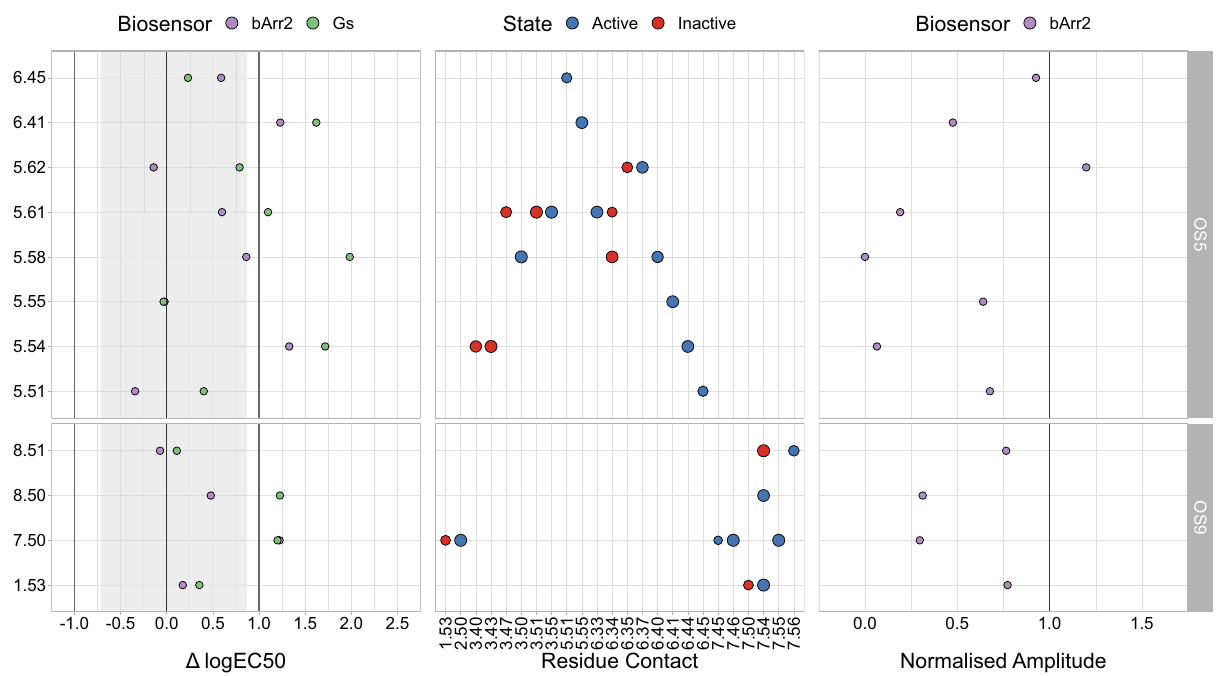
Fig. 4 Experimental data for OS5- and OS9-mutants in the β 2 AR. The y-axis depicts the position of the pocket residues (Ballesteros-Weinstein numbering 35 ). The left panel shows the difference between the mutant logEC 50 and the mean wt logEC 50 values (logEC mut the normalised amplitude (Amp mut /Amp wt ) of the extent to which β -arrestin2 was recruited. While in the left plot a value of 0 corresponds to no potency changes, a value of 1 in the right plot corresponds to no changes in ef fi cacy compared to wt. The greyed out area indicates minimal and maximal potency shifts of multiple G α s wt measurements. The central panel depicts interhelical residue contacts of each of the mutated residues that are important in active (blue) or inactive (red) conformations of class A GPCRs in a similar manner to Supplementary Fig. 10 (normalised PCA coef fi cient cut-off: 0.7). The point size correlates with the normalised PCA coef fi cient for a given contact and can be seen as a direct measurement of importance for a given state. Part of the G α s data was also published in 65 . Source data are provided as a source_data.xlsx fi